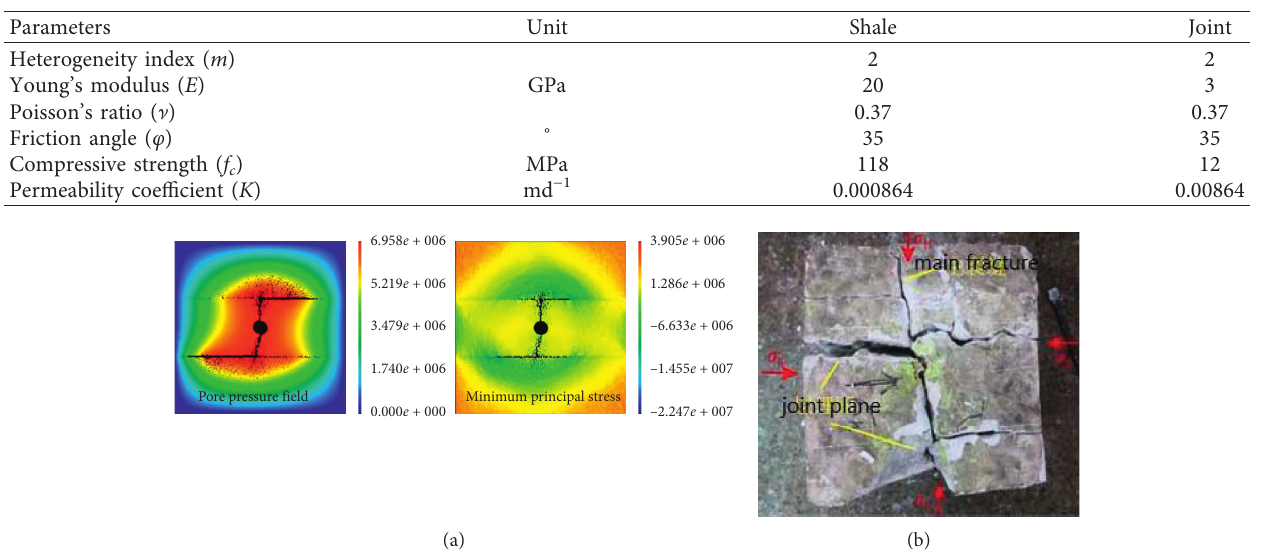
� 10MPa and σ � 5 MPa; (b) σ � 10MPa and σ � 8MPa; H V H V